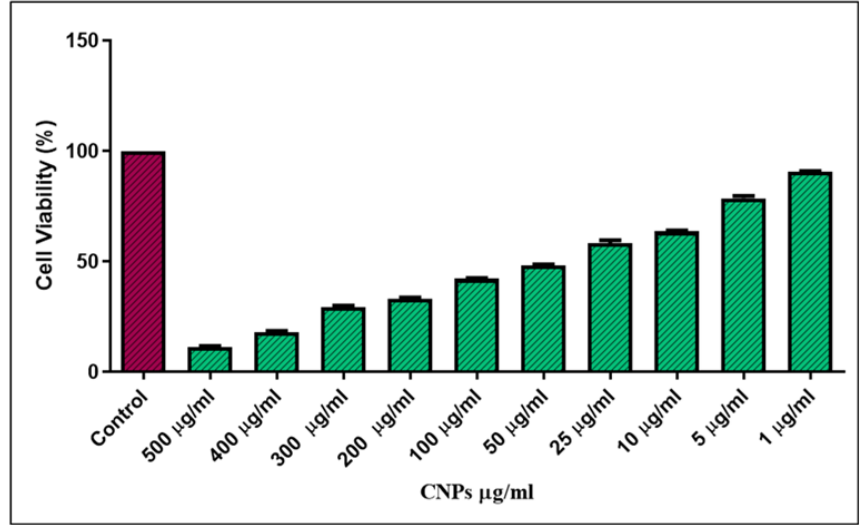
Figure 8. Cell viability percentage analysis by MTT assay with MAL-CNPs. Note: control: untreated cells.